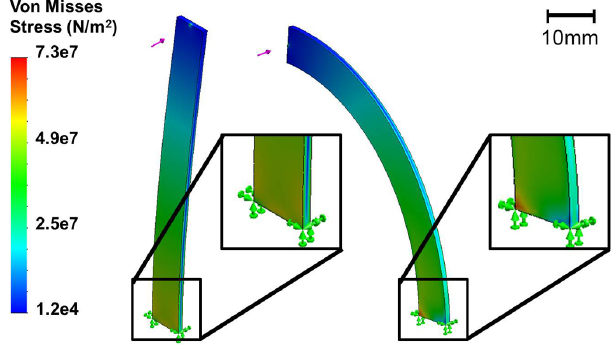
Figure 4. Finite element analysis of two cantilevered beams of the same properties under the same loading force. The stress concen- tration on the curved beam is